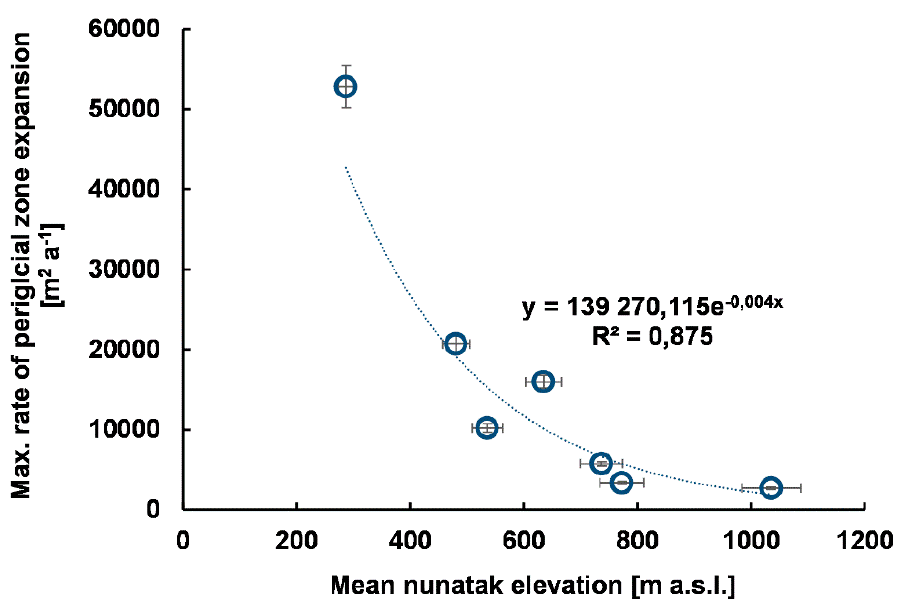
Figure 11. Statistical relationship between the maximum surface deglaciation rate for the selected nunataks in Spitsbergen and their mean elevation.